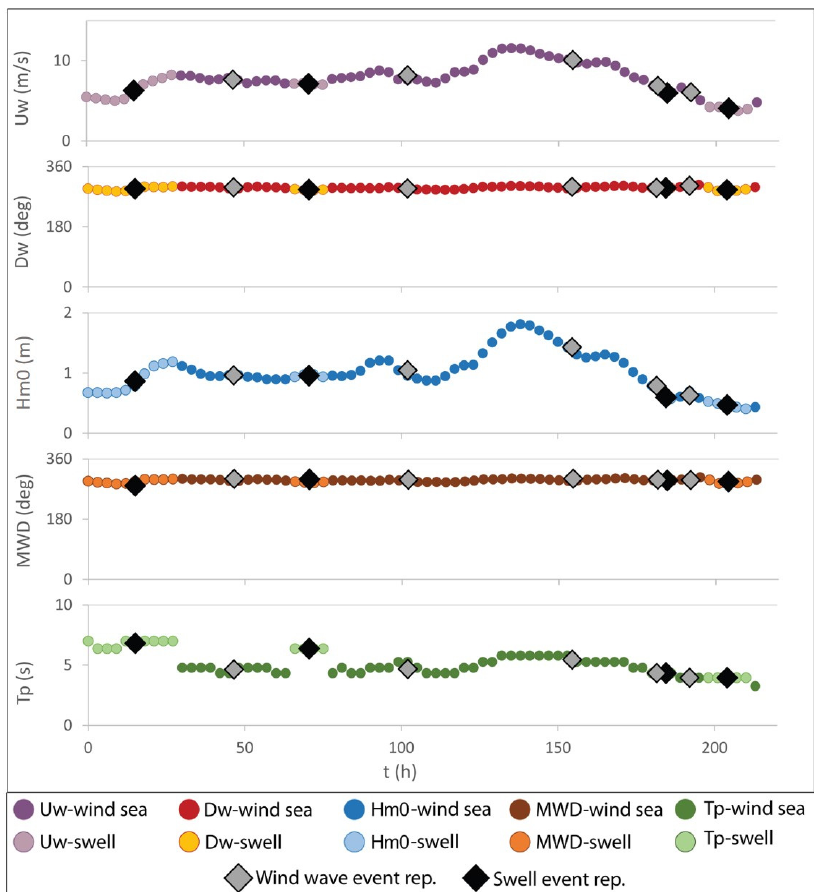
Figure 13. Wind velocity (Uw), wind direction (Dw), significant wave height (Hm0), mean wave direction (MWD), spectral peak wave period (Tp), and representative characteristics of wave scenarios covering a subset of time period (7_tf) of tombolo formation for swell and wind seas, extracted from the methodology applied.